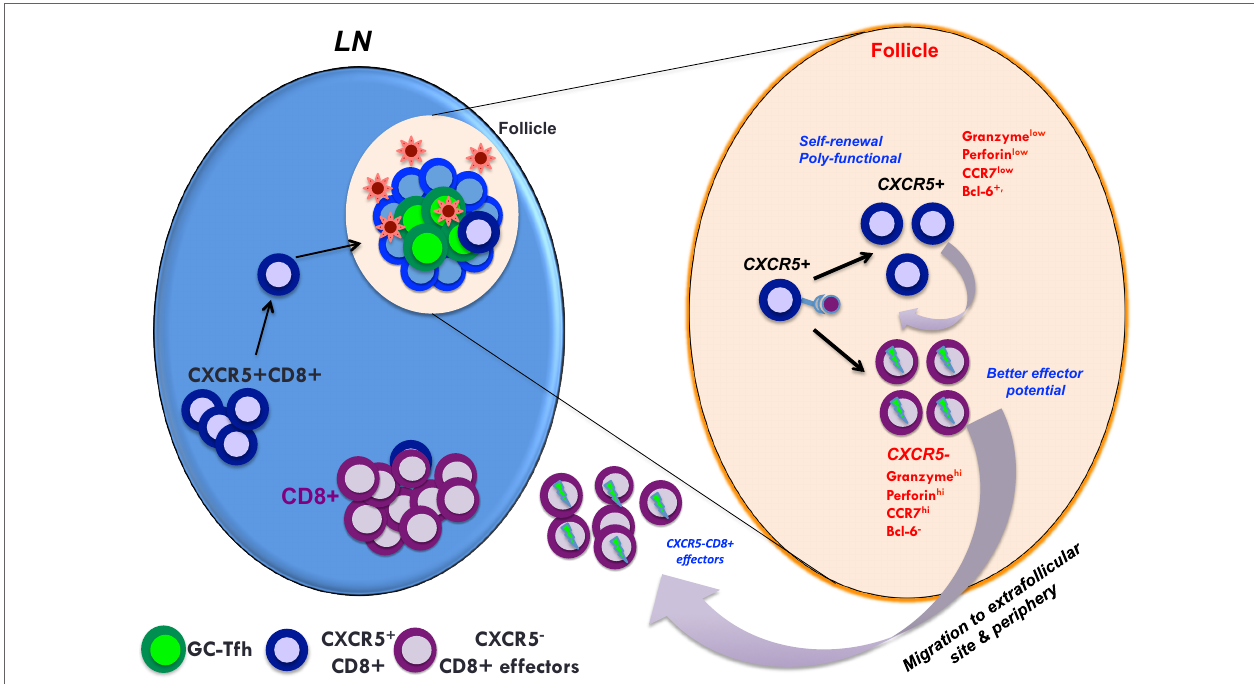
FiGURe 3 | A model showing the predicted role of follicular homing CXCR5 + CD8 T cells in controlled SIV infection. In controlled SIV infection, the population of virus-specific CD8 + T cells expressing CXCR5 increases in lymphoid follicles. These CXCR5 + CD8 T cells can give rise to both CXCR5 + and CXCR5 − CD8 T cells that may be important for the maintenance of anti-viral CD8 T cells in both follicular and extrafollicular compartments. Thus, generating anti-viral CXCR5 + CD8 T cells by vaccination and therapeutic interventions may be critical for the control of chronic HIV/SIV